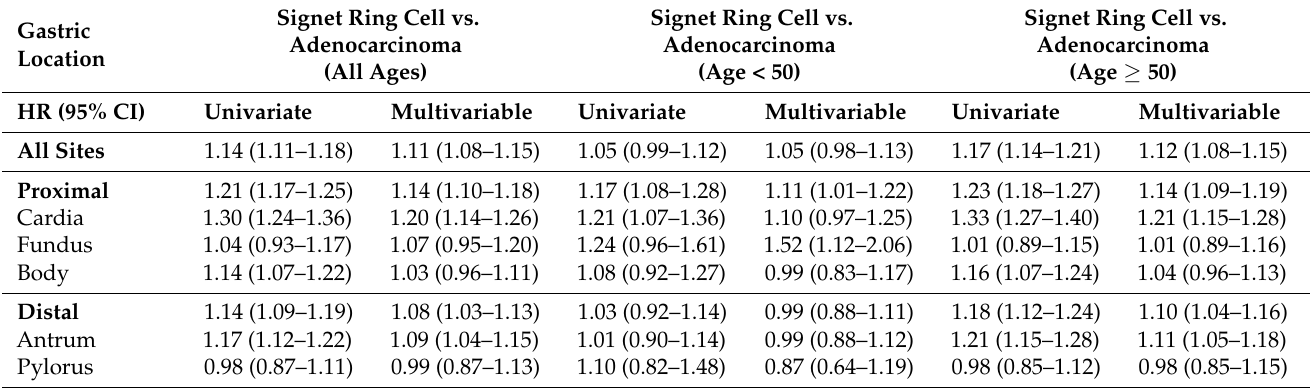
Table 3. Derived univariate and multivariable Cox-proportional hazard ratios of mortality for gastric signet ring cell adenocarcinomas versus conventional